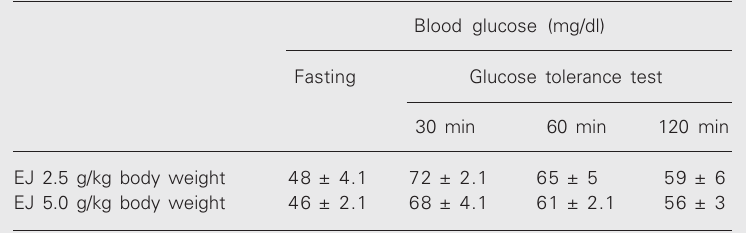
Table 4. Effect of a single oral dose of Eugenia jambolana seed powder on the glucose tolerance